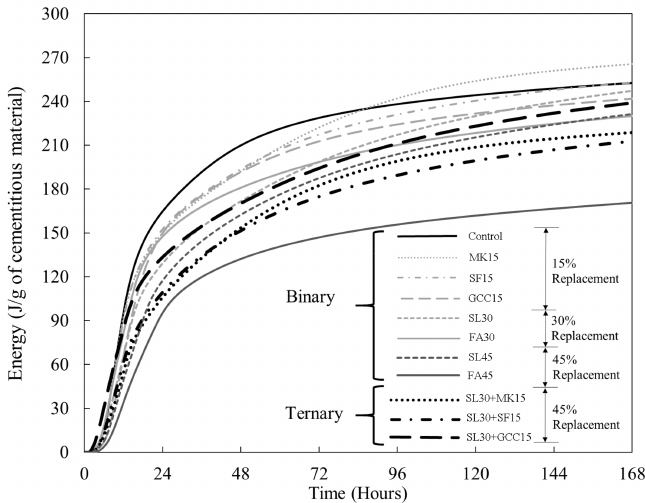
Figure 7. Heat of hydration of binary and ternary mixtures including ground calcium carbonate (GCC) in the 422 group.